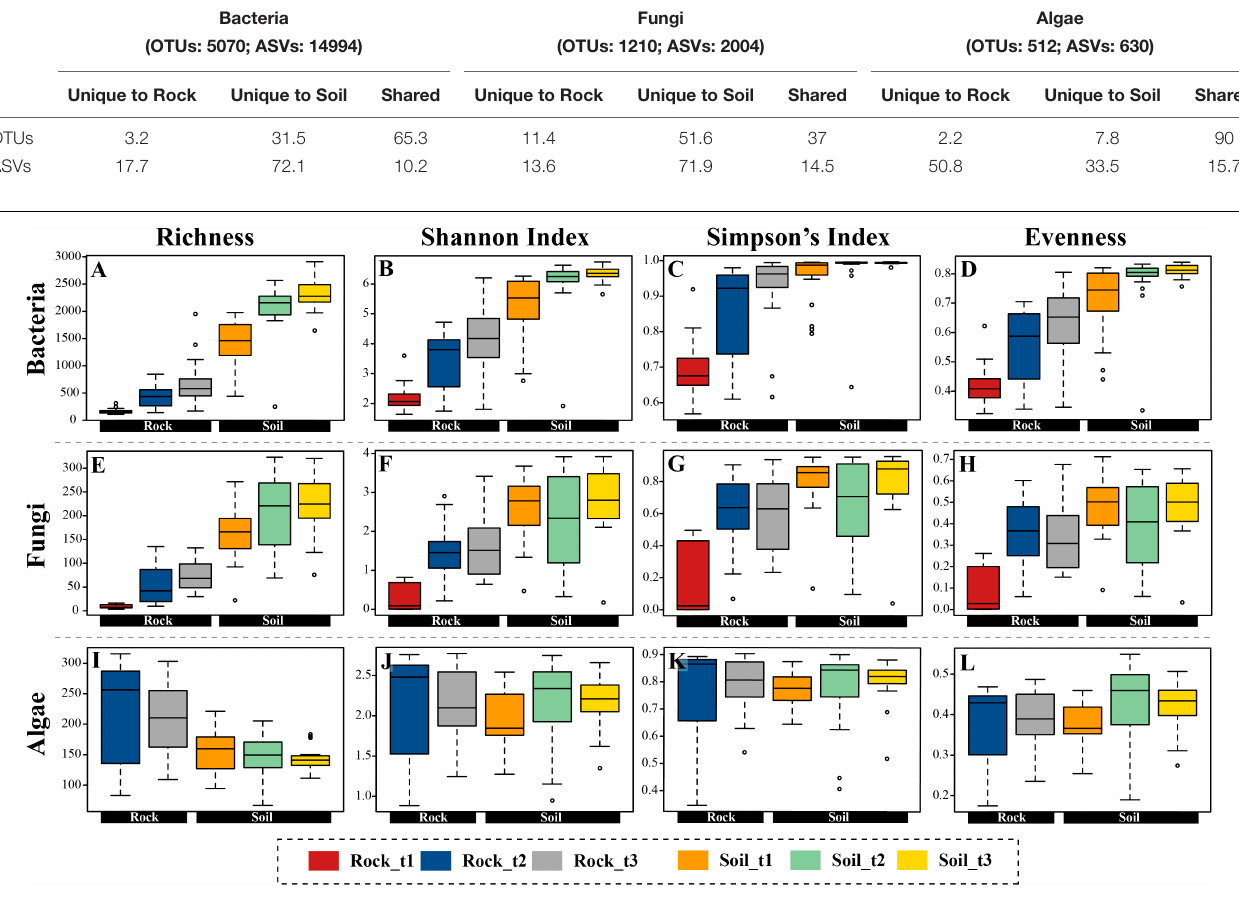
since exposure ( Supplementary Table S3 and